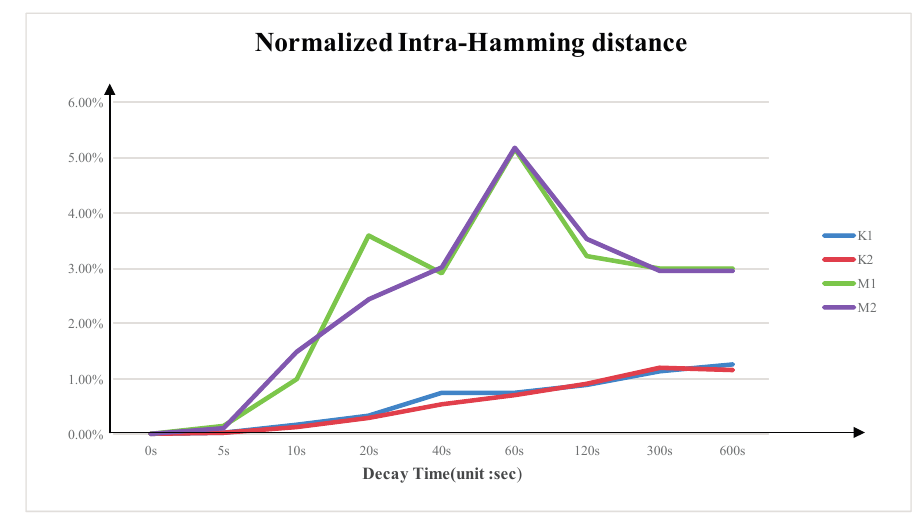
Figure 7. Normalized intra-Hamming distance for 4 DDR3 devices.